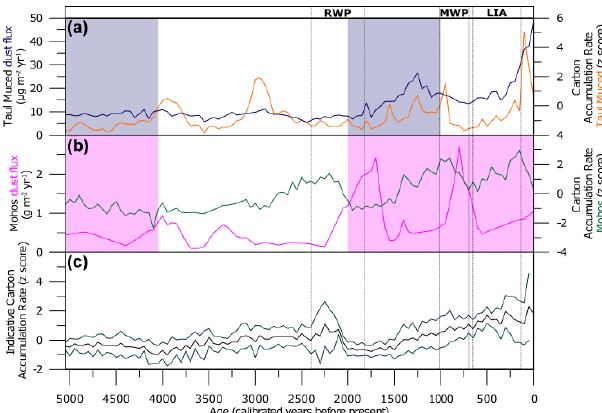
Figure 5. Comparison of dust fluxes and our reconstruction of the carbon accumulation rate (CAR). Panel (a) shows the dust flux re- constructed from T˘aul Muced as well as the corresponding CAR. Panel (b) shows the dust flux reconstructed from Mohos as well as the corresponding CAR. Panel (c) shows the CAR composite record. Coloured rectangles indicate a significant correlation be- tween the variable indicated by the colour and the CAR reconstruc- tion, as in Fig. 4. The Roman Warm Period (RWP), the Medieval Warm Period (MWP), and the Little Ice Age (LIA) are also indi- cated using vertical dashed